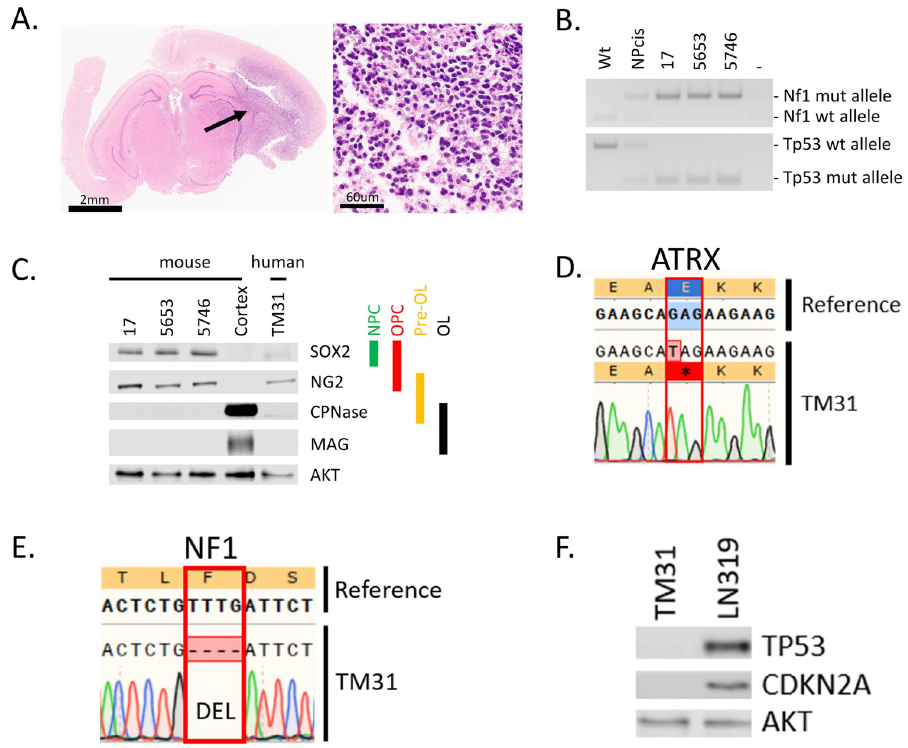
Fig 1. Characterization of cell lines. (A) H&E staining of tumor 5653, the arrow indicates the location of the tumor. The right panel shows a higher magnification. (B) Genotyping PCR on genomic wildtype mouse, genomic NPcis mouse (heterozygous for Nf1 and Tp53 ) DNA and DNA extracted from cell lines 17, 5653 and 5746. The glioma cell lines show complete loss of the wildtype allele for Nf1 and Tp53. (C) Western blot shows the expression of markers consistent with OPC lineage origin of our cell lines. SOX2 is expressed in Neural Progenitor cells (NPC) and Oligodendrocyte precursor cells (OPC); NG2 is expressed in OPCs. Markers (CPNase and MAG) expressed in pre- oligodendrocytes (pre-OL) or mature oligodendrocytes (OL) are not present, highlighting the progenitor status of our lines [22]. (D) The ATRX mutation (E2281 � ) present in TM31 was confirmed using sequencing. Top shows the reference genome DNA and protein sequence, bottom shows the TM31 sequence with STOP mutation. (E) The homozygous 4bp NF1 deletion (p.LF1247fs � 18) present in TM31 was confirmed using sequencing. Top shows the reference genome DNA and protein sequence, bottom shows the TM31 sequence with the homozygous 4bp deletion inducing a frameshift. (F) Western blot for TP53 and CDKN2A, showing that both genes are absent in TM31, but not in glioma line